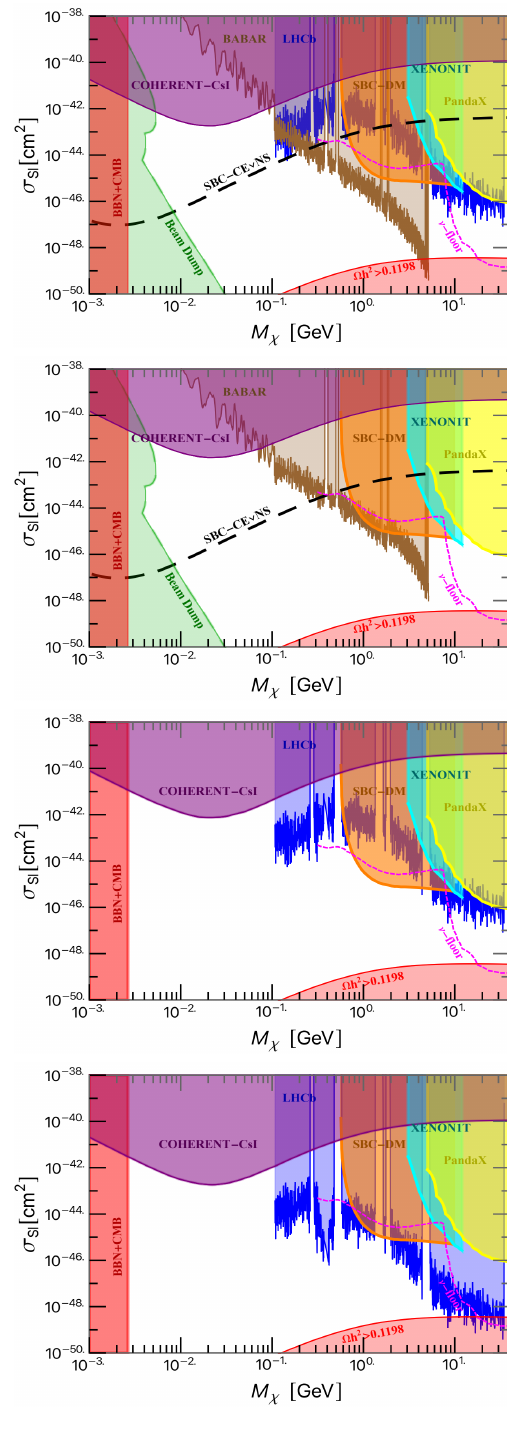
Figure 3 . Same as figure 2 but for MII U(1) 0 models as given by table